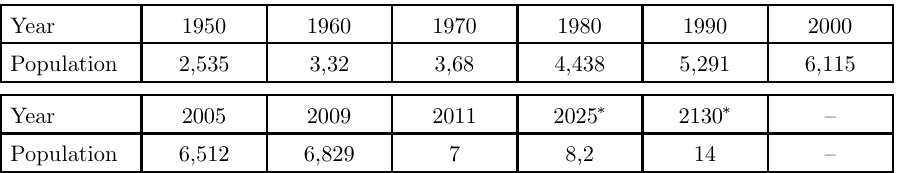
Number of inhabitants of the world in the years 1950–2130 * (in billion)